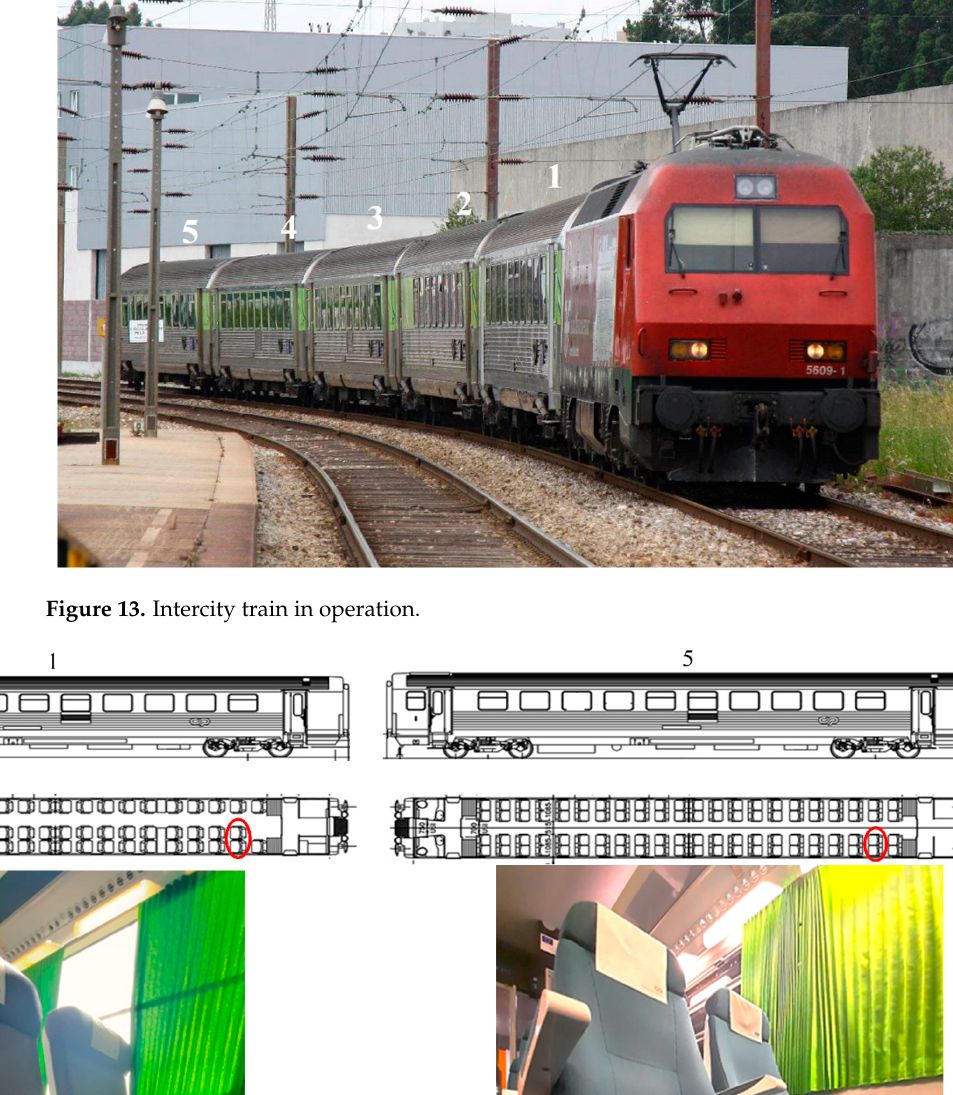
Figure 13. Intercity train in operation.